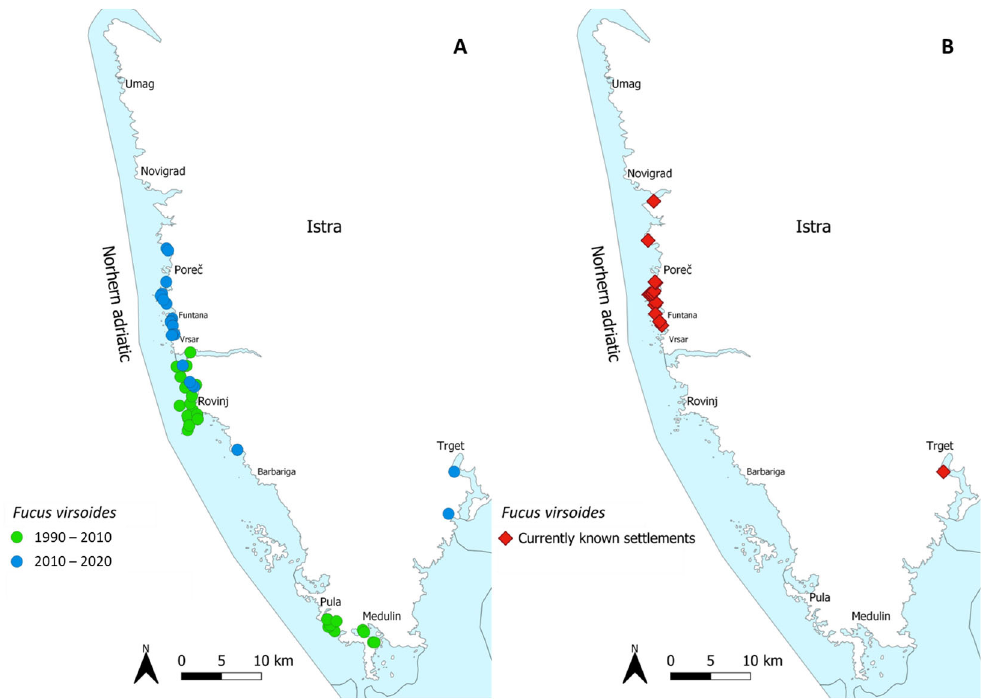
Figure 1. Historically known se tt lements of Fucus virsoides along the Istrian coast from 1990–2020 ( A ) and its current known se tt lements from mapping in 2021 ( B ).